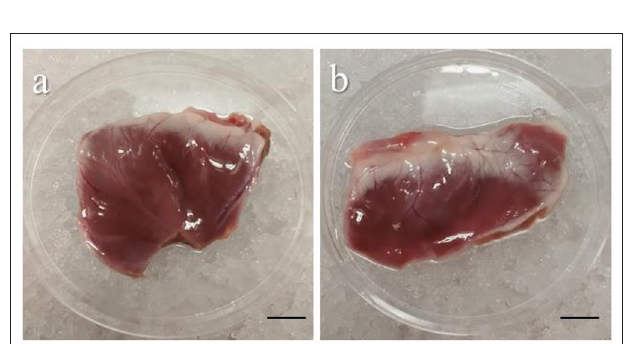
FIGURE 2 | Representative images of piglet’s ventricles after excision. Images showing the left (a) and the right (b) ventricles carefully removed from a piglet heart after heart perfusion. Freshly dissected tissue can be stored for up to 1h in cold cardioplegia without affecting the epicardial viability. Scale bar, 1cm. Source: Maselli et al.